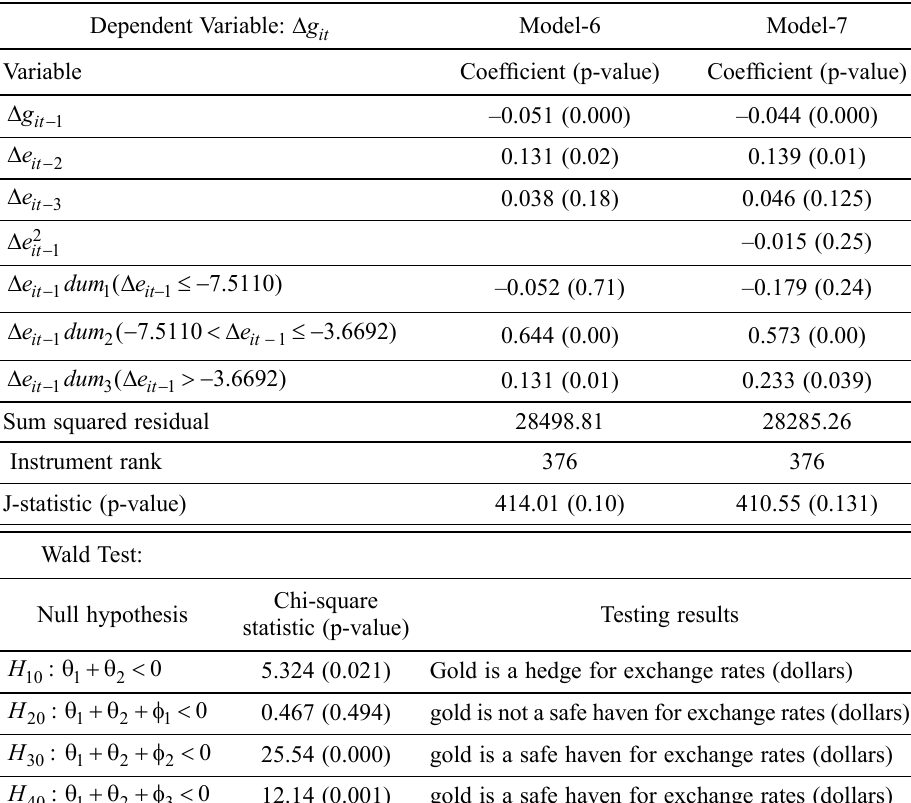
Table 6. Estimation result of the dynamic panel threshold